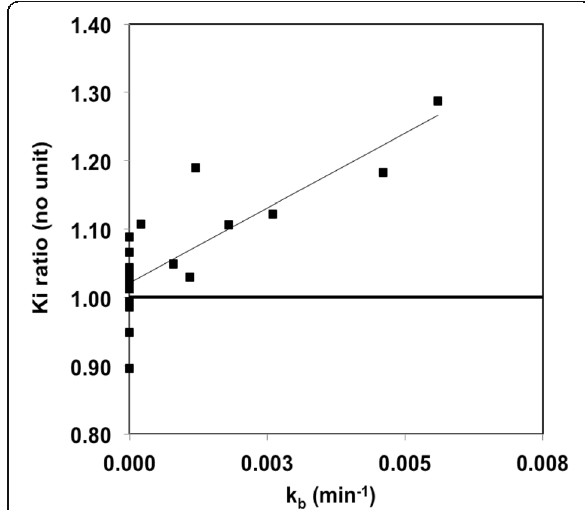
Fig. 5 Ki ratio of 3P-KMA/Patlak versus k b : y = 43.679 x + 1.022, R = 0.801; P < 0.001